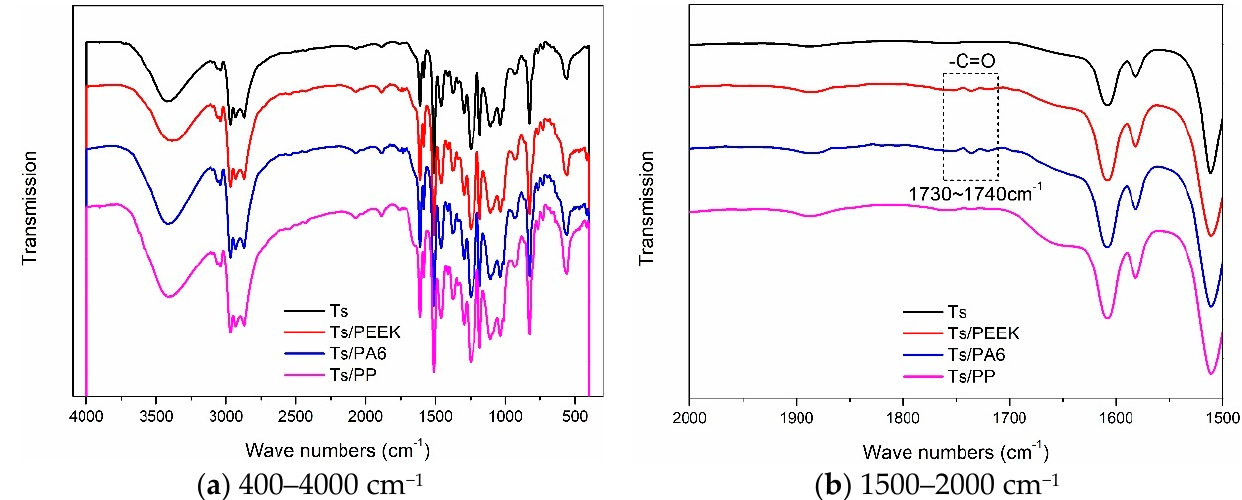
Figure 14. Effects of thermoplastic resin fillers on infrared transmission of Ts resin of ( a ) 400–4000 cm − 1 and ( b ) 1500–2000 cm − 1 .